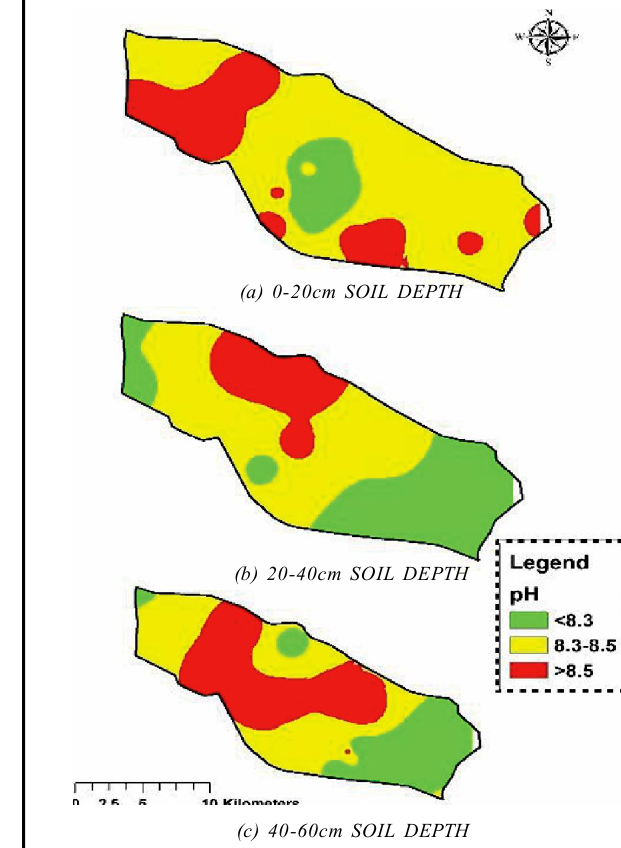
FIG. 7. SPATIAL DISTRIBUTION OF SOIL EC